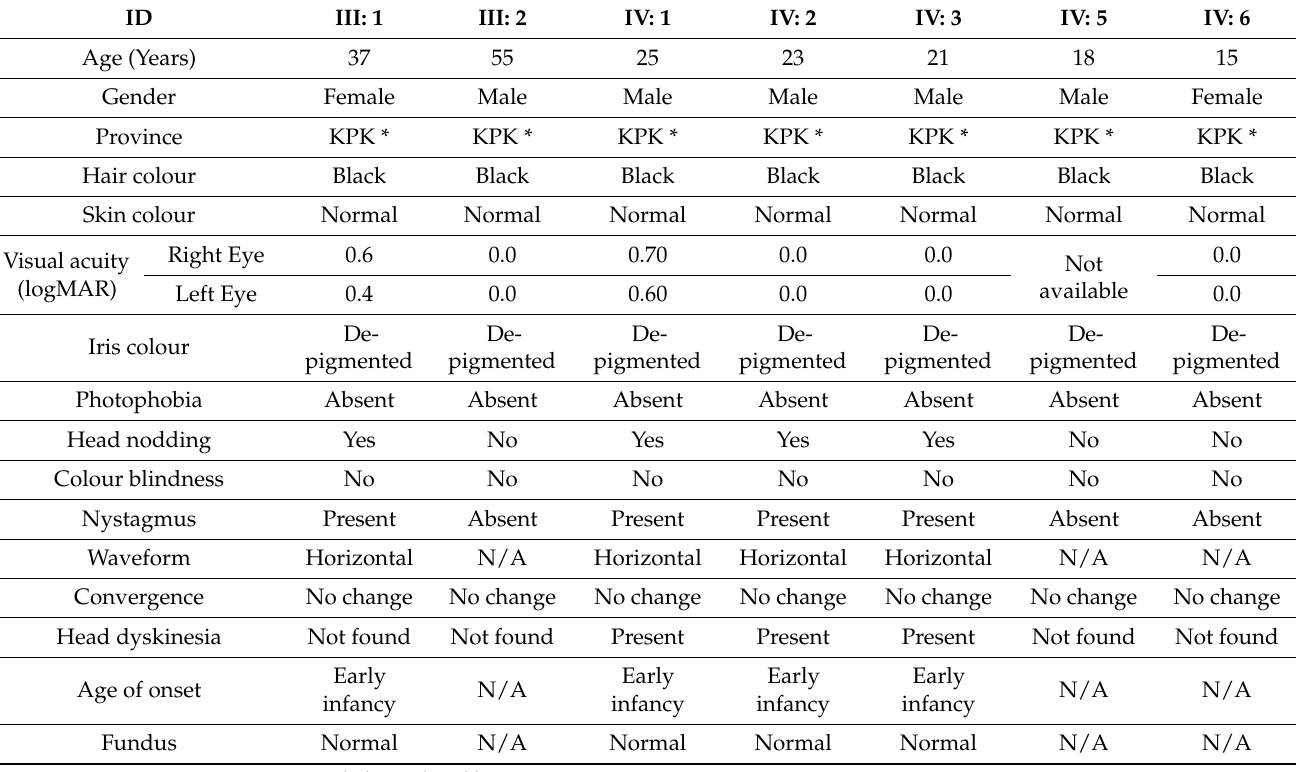
Table 1. Clinical re-evaluation details of Family PKNYS07.